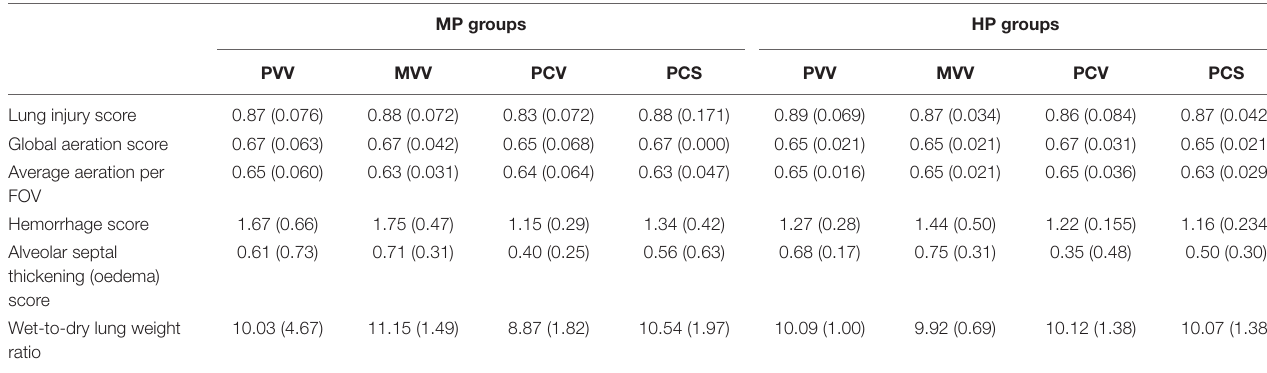
TABLE 2 | Histology parameters obtained in the rabbits ventilated with physiological variable ventilation (PVV), mathematically variable ventilation (MVV), pressure-controlled mode (PCV), and pressure controlled mode with regular sighs (PCS) at positive expiratory pressure (PEEP) levels of 6 and 9 cmH 2 O. MP